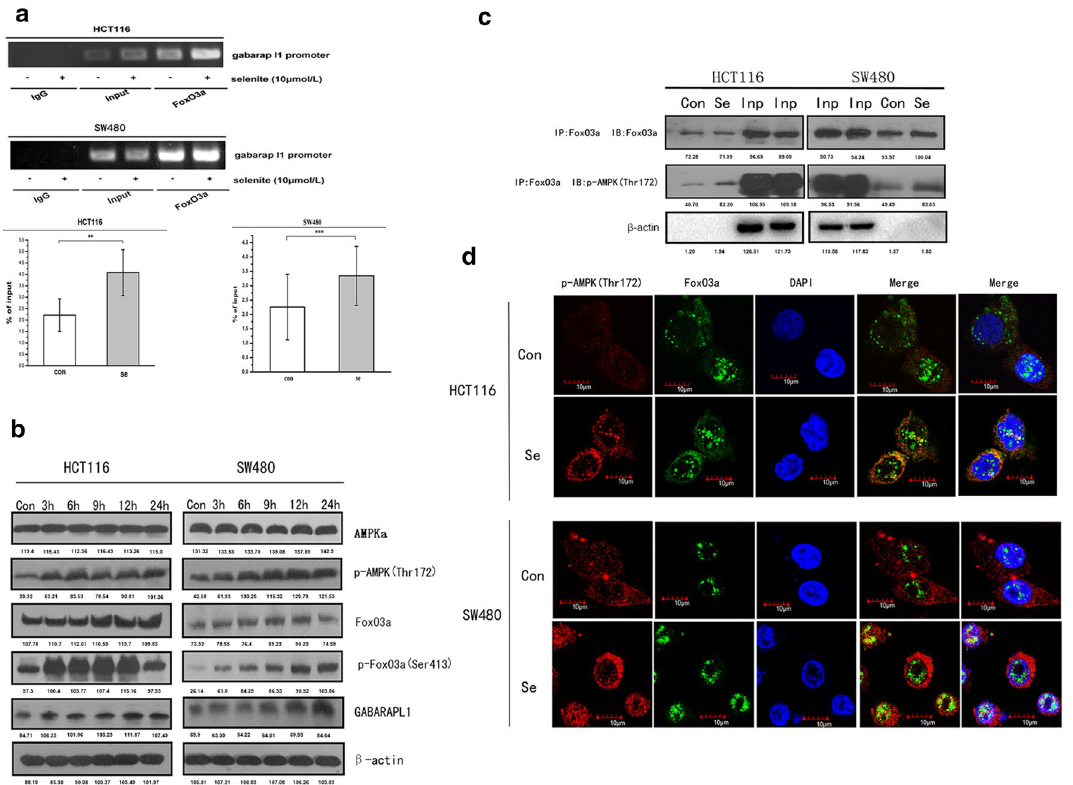
Fig. 2 AMPK activated FoxO3a responsible for GABARAPL-1 transcription. a Selenite treatment enhanced FoxO3a binding to gabarapl-1 promoter. The statistical graphs are presented as the mean ± S.D. of the three independent experiments, * p < 0.05. b Western blot analysis of AMPK and FoxO3a protein levels and phosphorylation levels during a 0–24 h time course in HCT116 and SW480 cells treated with 10 µM selenite. c Enhanced p-AMPK and FoxO3a interaction after selenite treatment. Co-immunoprecipitation experiment was conducted with FoxO3a antibody and subjected to western blot experiments incubated with p-AMPK or FoxO3a antibody. β-actin was used as a loading control. d Confocal analysis of p-AMPK and FoxO3a interaction in selenite-treated HCT116 and SW480 cells. Cells were incubated with pri- mary antibody against p-AMPK and FoxO3a then stained with Cy3 or FITC-conjugated secondary antibody. The nuclei were shown as blue signals. Scale bar, 10